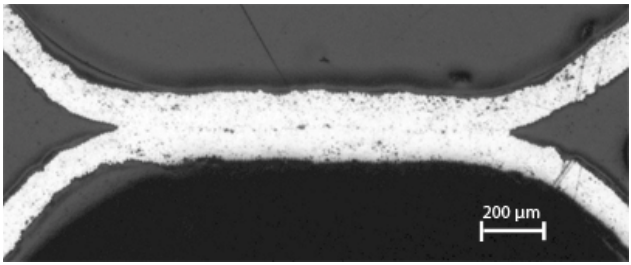
Figure 3. Optical microscopy image of the diffusion bonded contact between two adjacent hollow spheres.